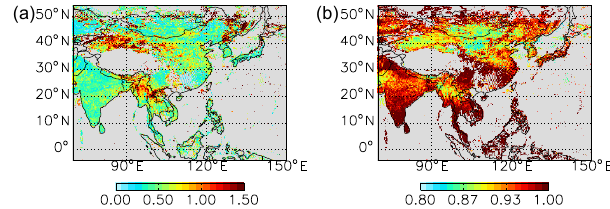
Figure 8. (a) AOD and (b) SSA at 354nm from OMI used in AMF calculation for March 2006 in clear sky conditions (cloud frac- tion<0.05).